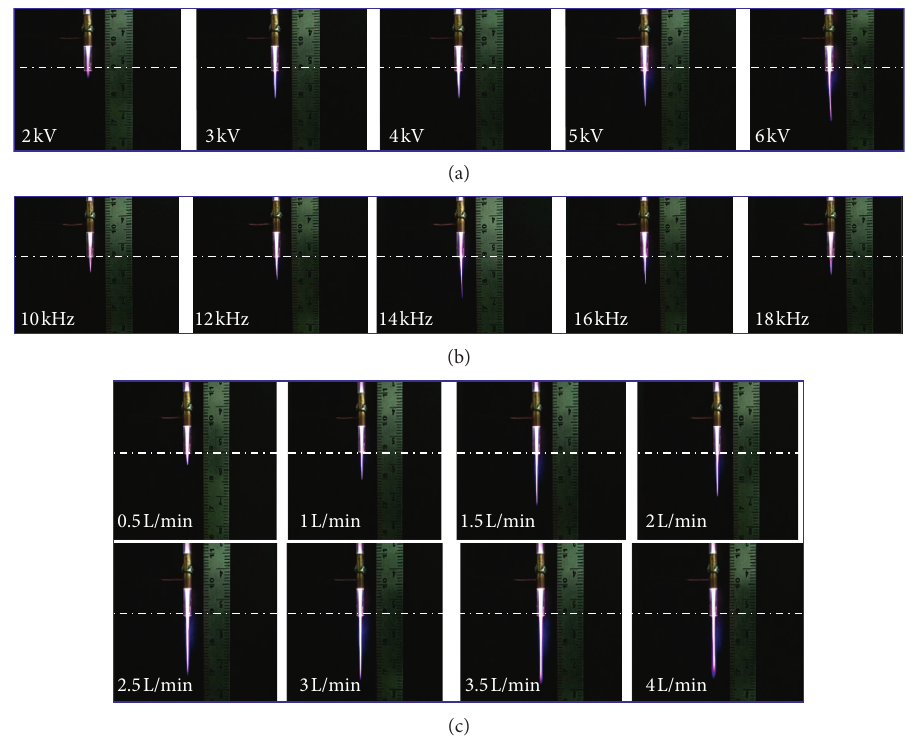
Figure 6: Photographs of He-plasma jets generated at different (a) applied voltages, (b) He flow rates, and (c) applied frequencies.